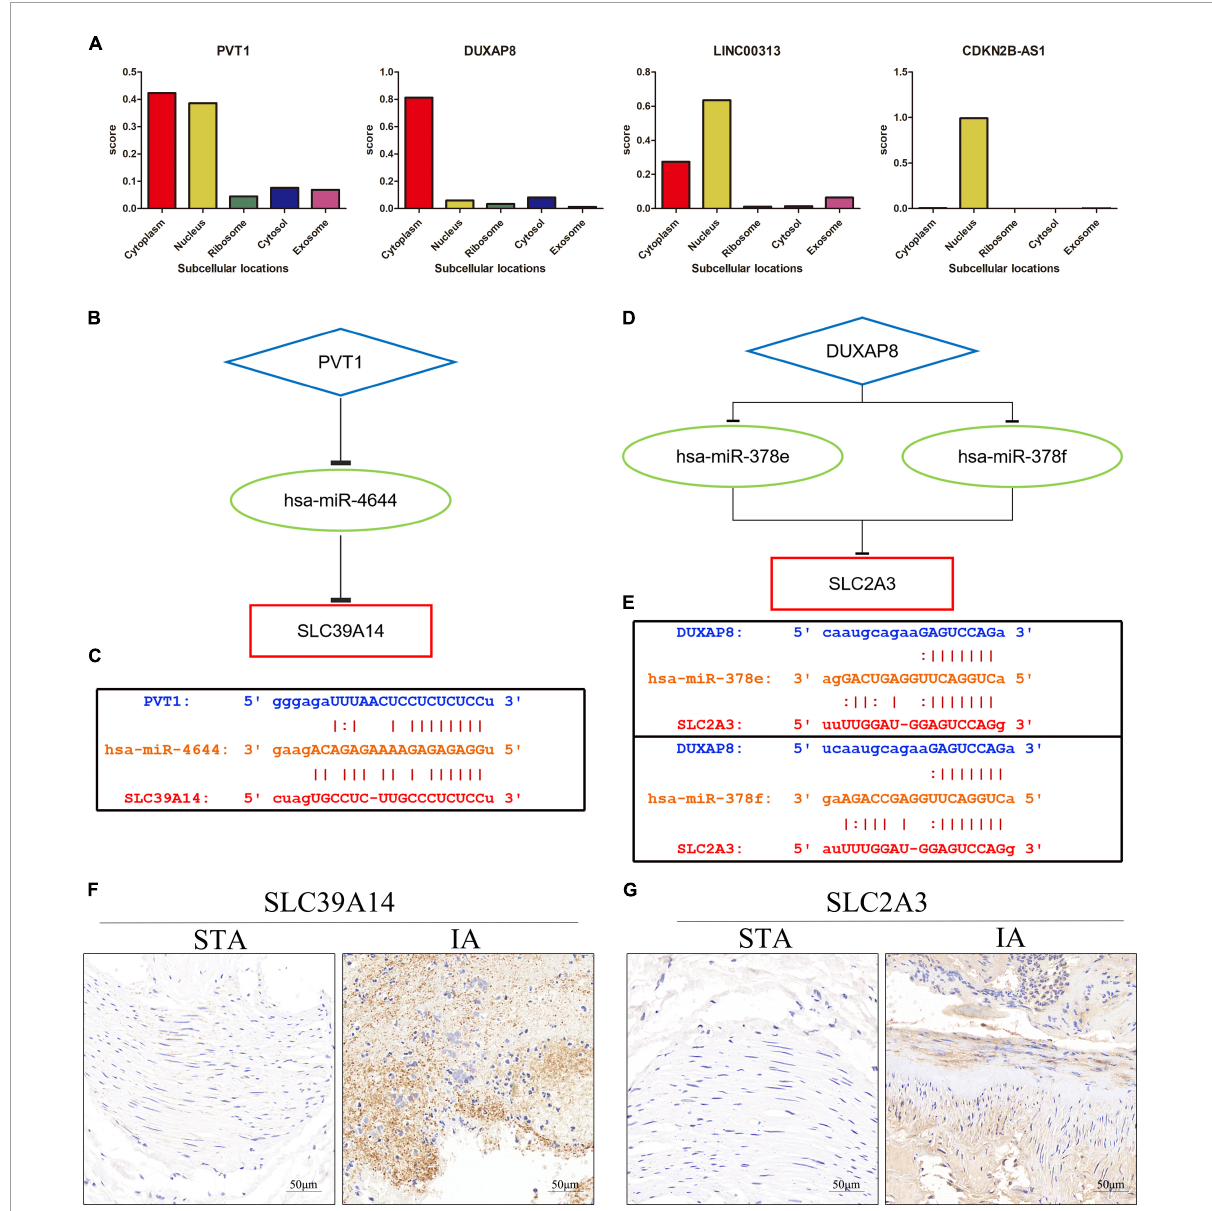
FIGURE6 Construction of the ceRNA network. (A) The cellular localizations of four DELs (PVT1, DUXAP8, LINC00313, and CDKN2B-AS1). (B) A schematic of ceRNA (PVT1-hsa-miR-4644-SLC39A14). (C) Base pairing between hsa-miR-4644, PVT1, and SLC39A14 as predicted by StarBase. (D) A schematic of ceRNA (DUXAP8-hsa-miR-378e/378f-SLC2A13). (E) Base pairing between hsa-miR-378e/378f, PVT1, and SLC39A14 as predicted by StarBase. (F) Expression of SLC39A14 in STA and IA tissue. (G) Expression of SLC2A3 in STA and IA